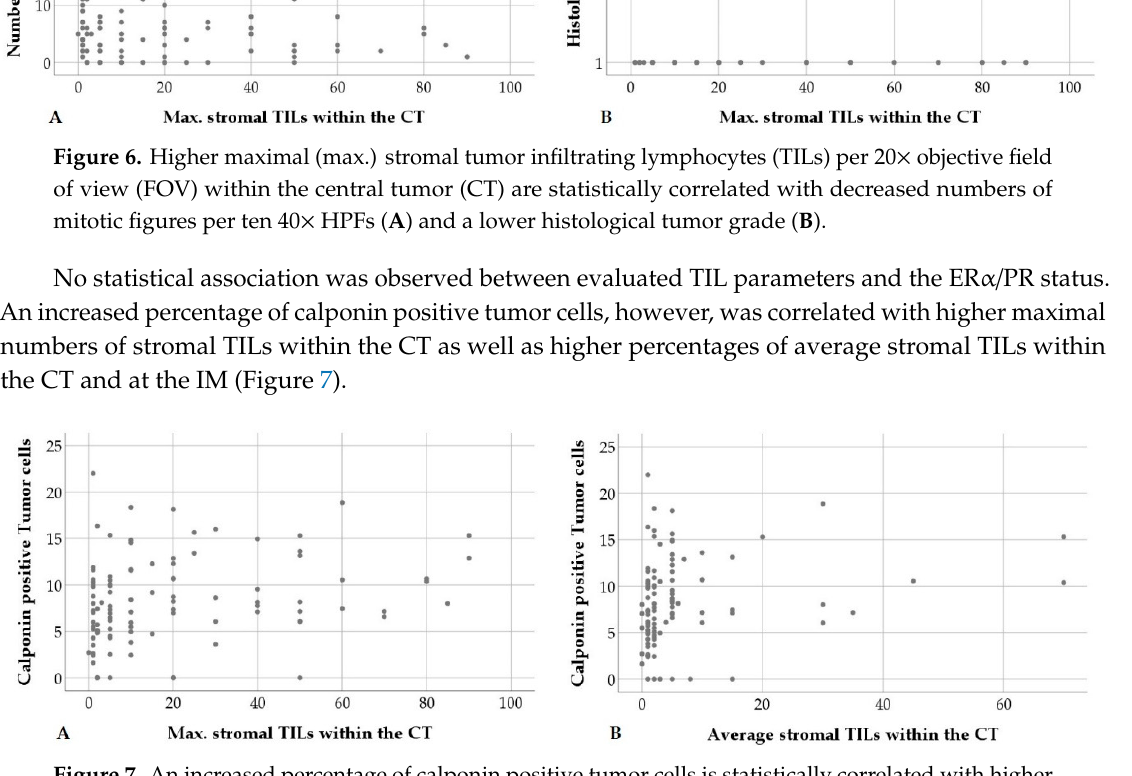
Figure 7. An increased percentage of calponin positive tumor cells is statistically correlated with higher maximal (max.) stromal tumor infiltrating lymphocytes (TILs) per 20 × objective FOV within the central tumor (CT), ( A ) and higher average stromal TILs within the central tumor ( B ).